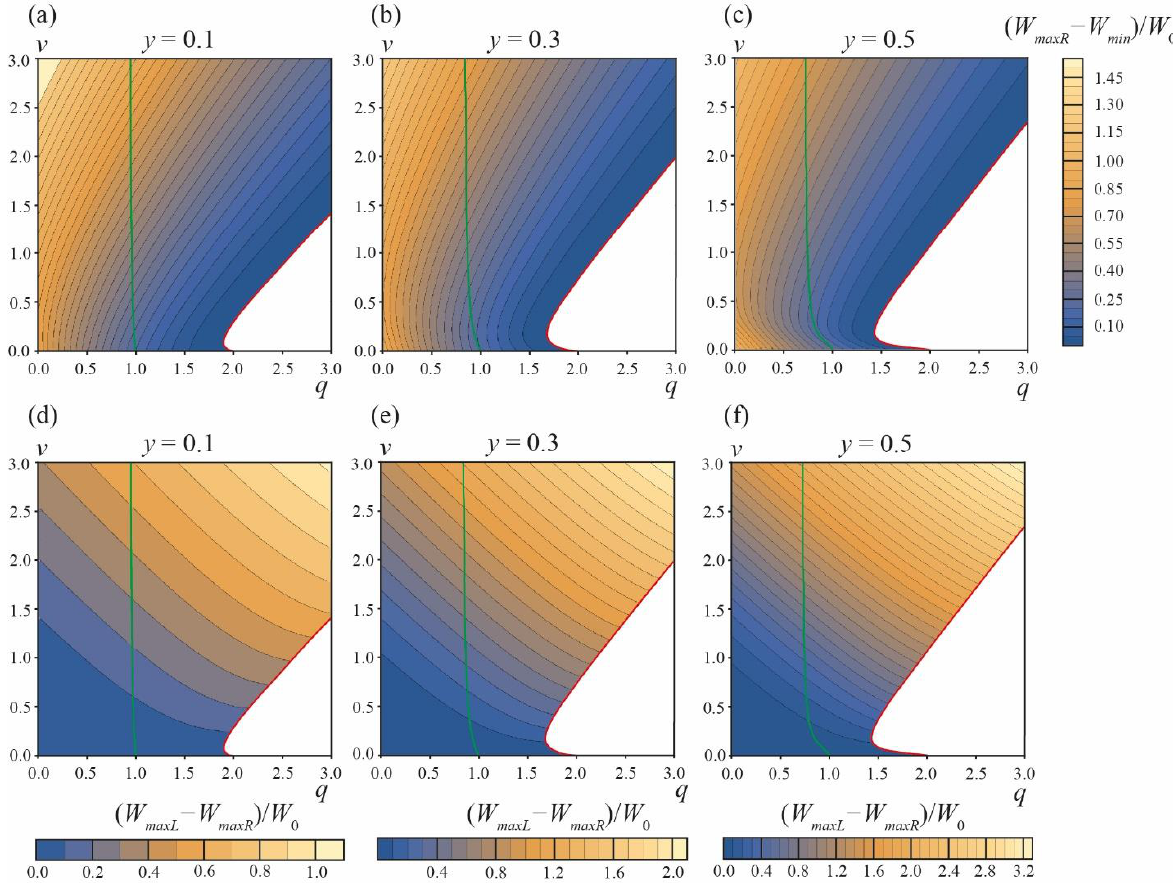
Figure 4. Energy landscape of the formation of two separate vesicles and the formation of the DMV. ( a – c )—The values of energy barrier ∆ W sep = W maxR − W min of the formation of two separate vesicles for area fractions of the A phase y = 0.1 ( a ), y = 0.3 ( b ), y = 0.5 ( c ). ( d – f )—The difference in the energy barriers ∆ W = W maxL − W maxR of the DMV formation and the formation of two separate vesicles for area fractions of the A phase y = 0.1 ( d ), y = 0.3 ( e ), y = 0.5 ( f ). Green curves are right boundaries of the q , v parameter regions, where W min = W eff ( α min ) ≤ 0. Red curves are the left boundaries of the q , v parameter regions, where the formation of two separate vesicles is barrier-free (white zones in right bottom corners of the plots).